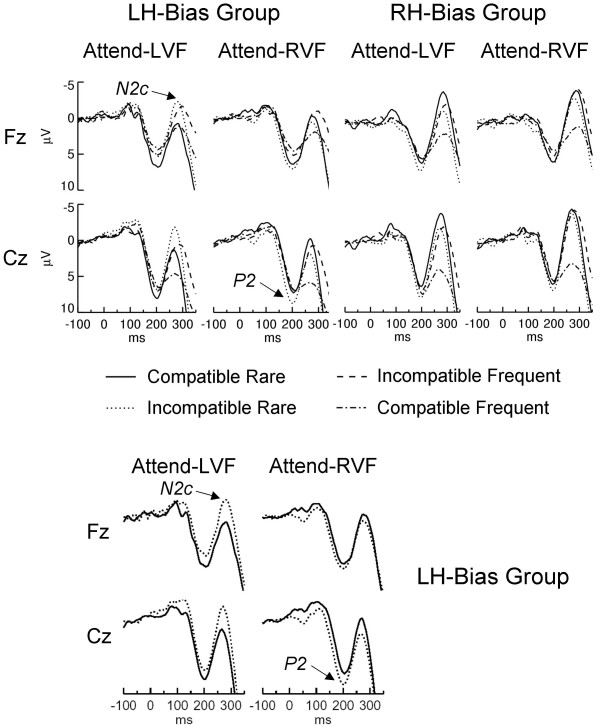
Grand average ERPs (early portion of epoch). ERPs in the early portion of the epoch at Fz and Cz are shown to highlight the N2c and P2 effects. In the bottom panel, only the Rare stimulus ERPs are shown for the LH-Bias Group.